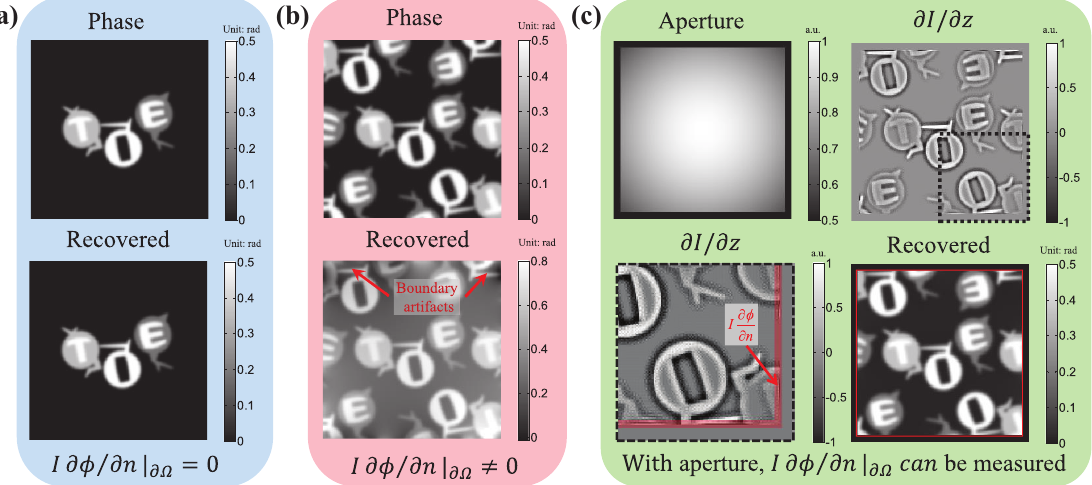
Figure 15. Phase retrieval simulations for different types of objects: ( a ) an isolated object located in the central field of view (FOV) (FFT-based solver gives accurate reconstruction); ( b ) a complex object extending outside the image boundary (FFT-based solver produces large boundary artifacts); and ( c ) DCT solver with a hard aperture (the inhomogeneous boundary conditions can be measured at the boundary, which produces accurate phase reconstruction even if the object is located at the aperture